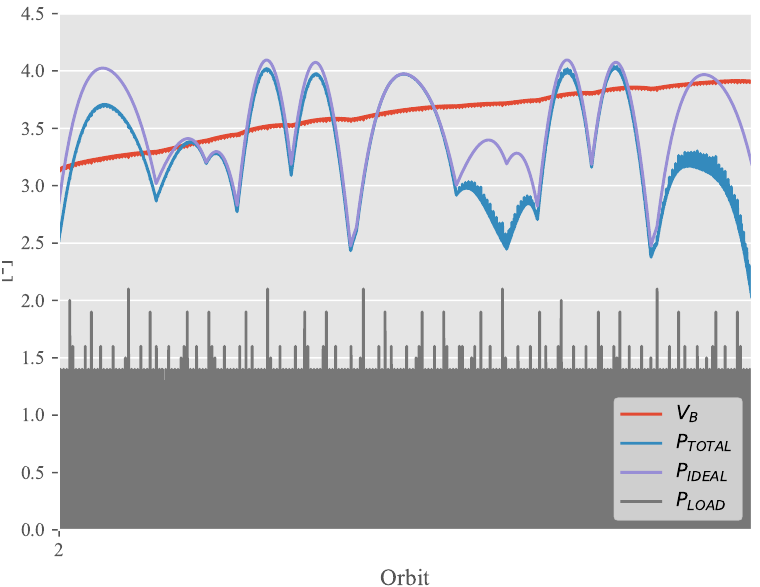
Figure 20. The total input power of satellite (under the MPPT algorithm) compared with the ideal power that could be delivered in a given orbit.